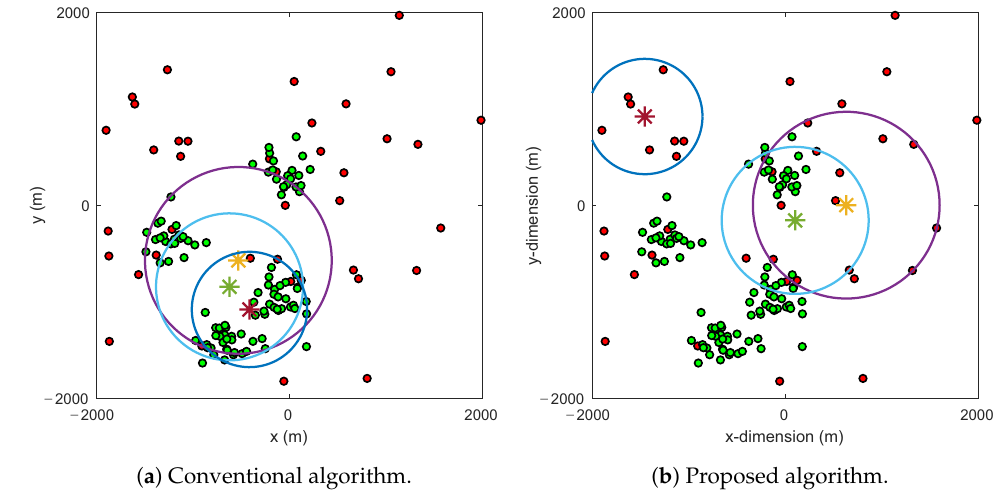
Figure 5. The optimal position of the UAV using the conventional and proposed algorithms for different urban environments; L th = 103 dB, a = 2000 m, M = 100, N =